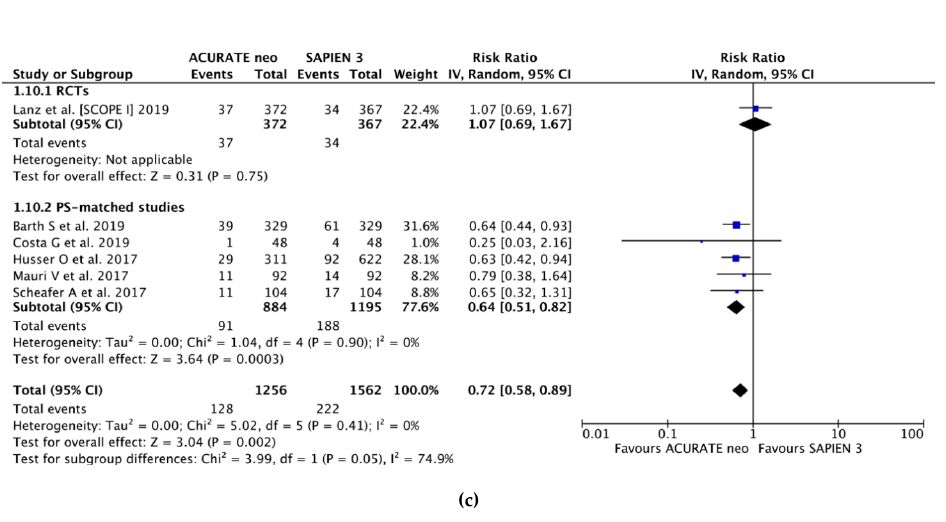
Figure 3. Individual and summary risk ratios with corresponding 95% confidence intervals for the comparison of ACURATE neo vs. SAPIEN 3 in the analysis of clinical outcomes: ( a ) early safety, ( b )·device success and ( c ) permanent pacemaker implantation.